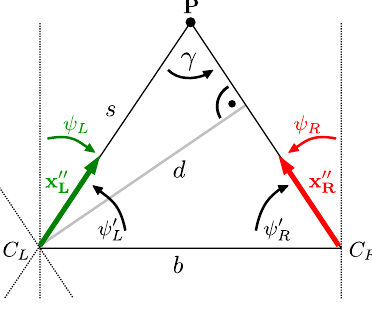
(cid:48)(cid:48) and x (cid:48)(cid:48) are defined L R